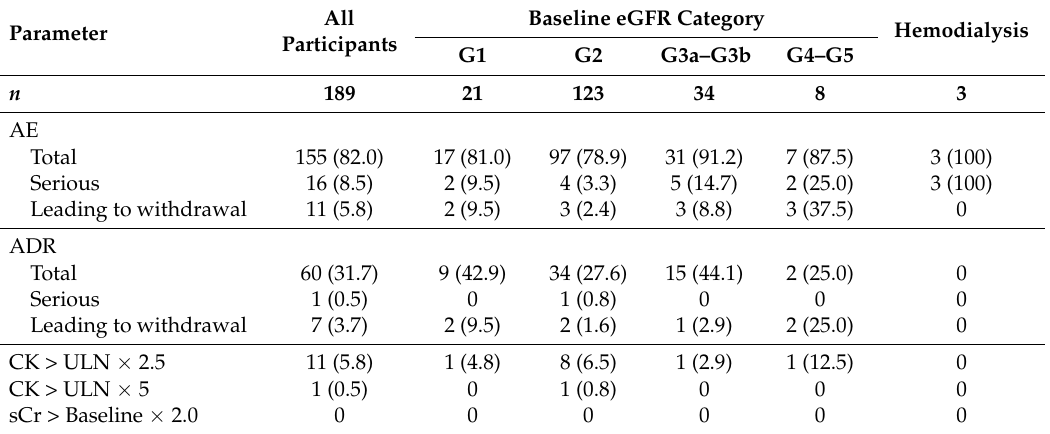
Table 4. Summary of AEs and